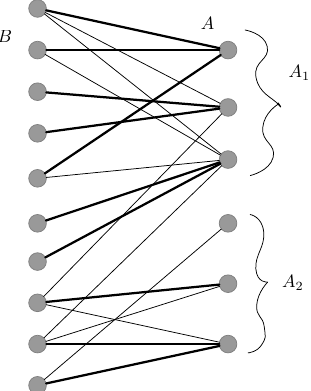
Figure 3. An illustration of a balanced expansion for q = 3 and with w ( v ) = 1 for every vertex v . The assignment f is depicted with bold